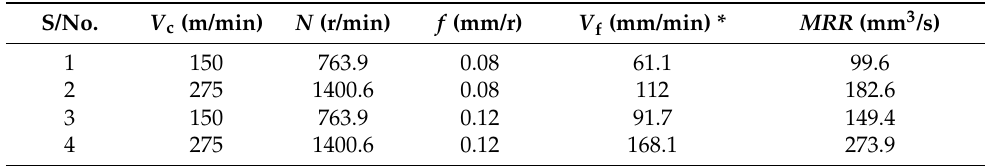
Table 2. The average material removal rates for the four cutting speed–feed rate combinations used in the